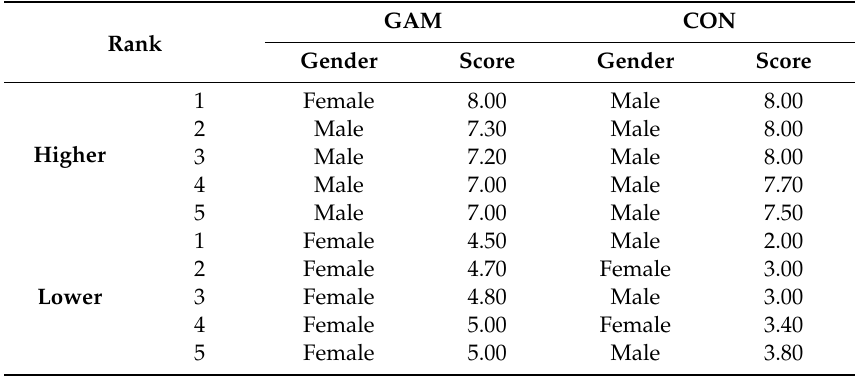
Table 7. Percentiles of qualifications in final exam (GAM vs. CON). Table 8. Score and gender of best and worst marks in final